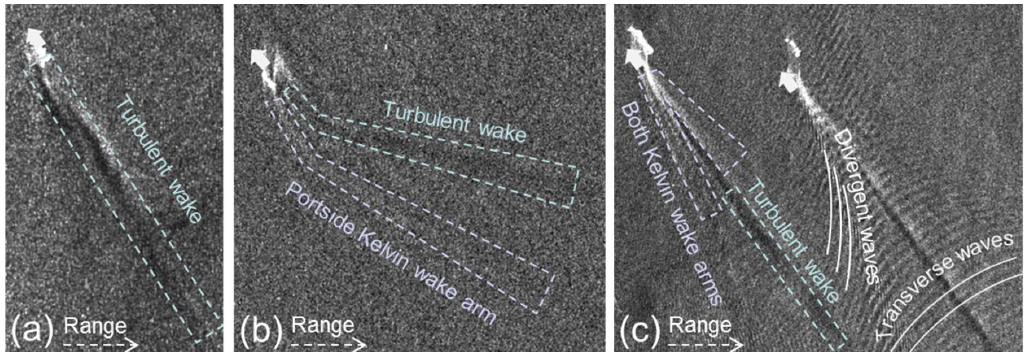
(Figure 10a), medium with AIS-Vessel-Velocity between 4 m/s and 9 m/s (Figure 10b) and fast with AIS-Vessel-Velocity above 9 m/s (Figure 10c). The differences between these classes are connected with forcing waves of different amplitude, period and propagation. For example, for low speed vessels the Kelvin waves and their SAR signature are weaker than the SAR signatures of turbulent wakes. Remote Sens. 2019 , 11 , x FOR PEER REVIEW